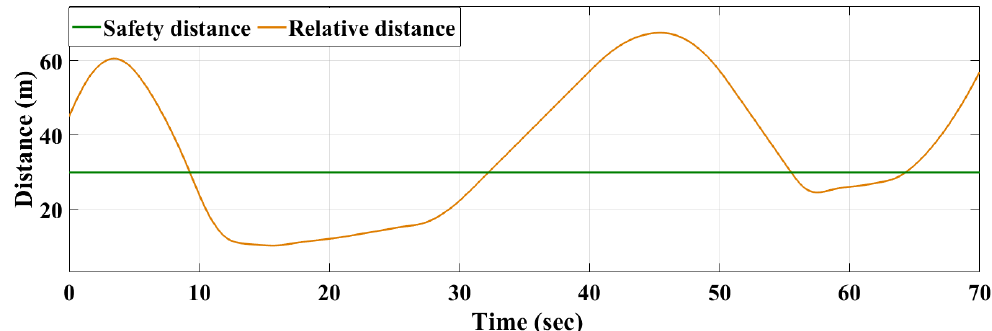
Figure 17. RL-based controller’s response—MATLAB Simulink.